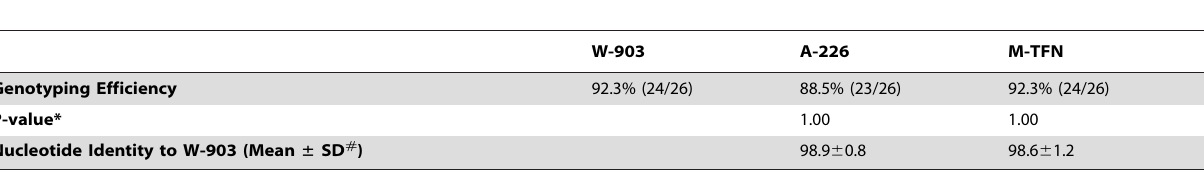
Table 1. Genotyping efficiency and nucleotide sequence identities of 26 DBS specimens with a VL $ 1000 copies/mL and collected on W-903, A-226, and M-TFN filter papers.